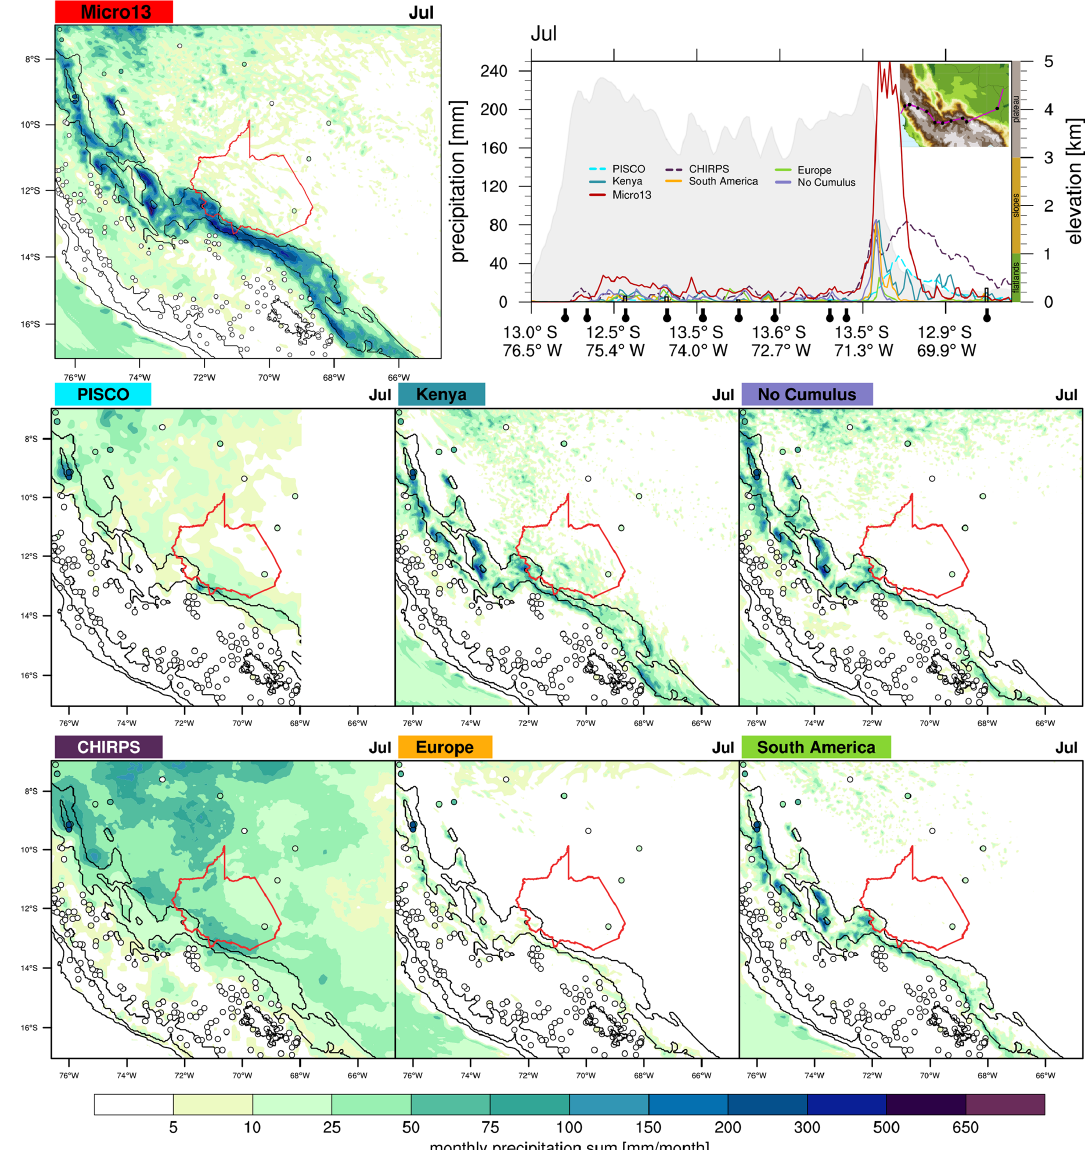
Figure 7. Same as Fig. 6, but for July, which represents the dry